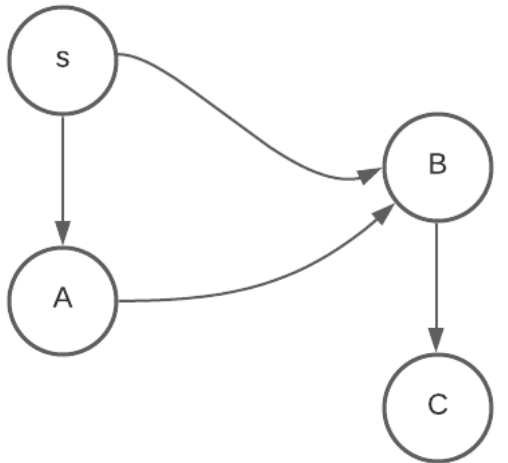
Figure 5. Underlying static graph for temporal graphs of Figures 1 and 2.